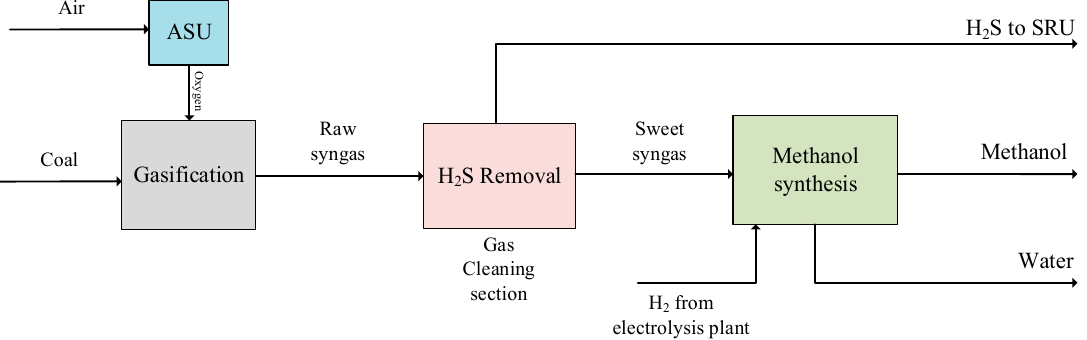
Figure 5. Block flow diagram for the modified design-3 (MD3-CTM) process.